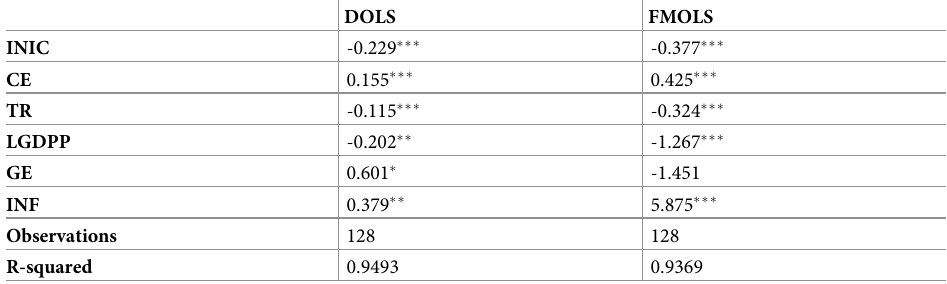
Table 7. Empirical findings on the effects of national intellectual capital on the shadow economy using the DOLS and FMOLS